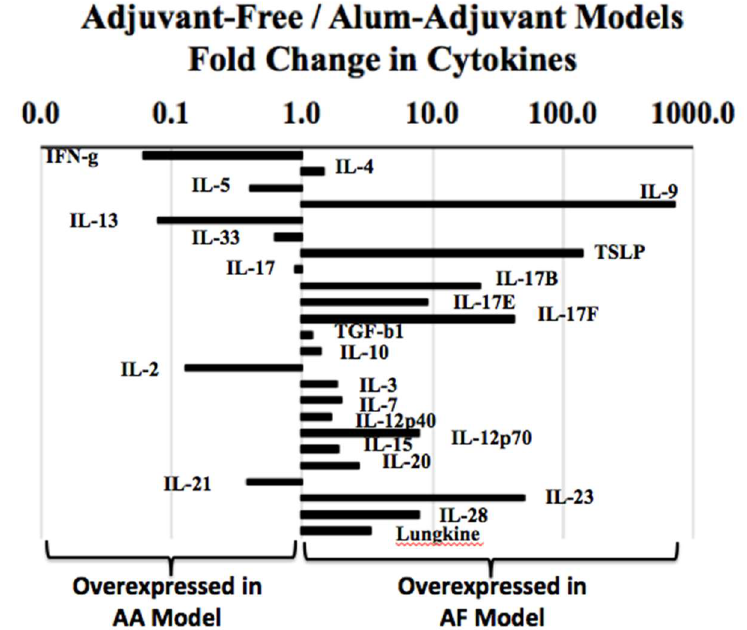
Figure 6. Analysis of in vivo activation of cytokines in the spleen in adjuvant-free vs. alum adjuvant mouse models of wheat allergy. Spleen tissues were collected from the experimental groups of mice in the AF vs. AA models, and used in the cytokine protein analysis, as described in the methods. Using the pg/mg spleen protein content, the fold changes in the cytokines in the AF vs. AA models were determined as shown. Data shows that different sets of cytokines are overexpressed in vivo in the AF vs. AA models, indicating the different mechanisms of wheat allergenicity in these two types of models. Table 1. Identification of in vivo immune markers for intrinsic wheat protein allergenicity in an adjuvant-free mouse model.